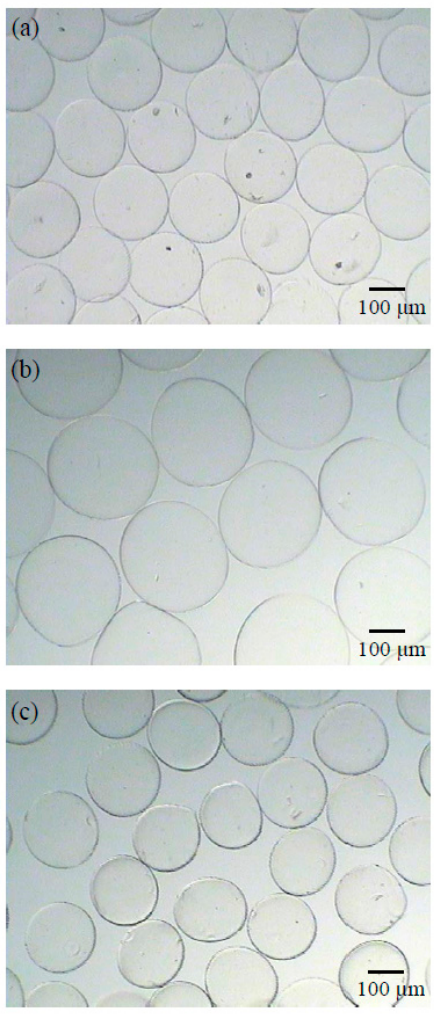
Figure 5. Optical microphotographs of: ( a ) ALG; ( b ) CS/ALG; and ( c ) QAC/ALG microspheres after soaking in deionized water.